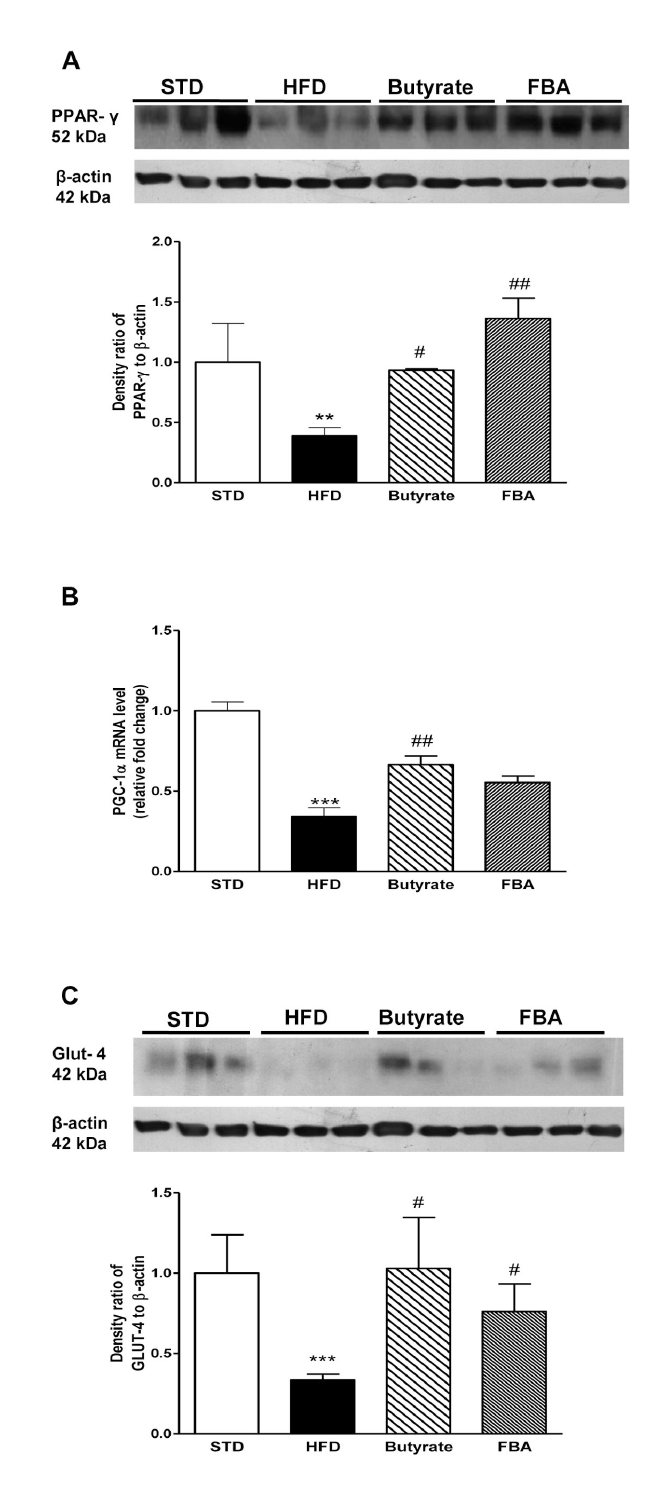
Figure 6. Butyrate and FBA are able to modulate metabolic proteins in adipose tissue. Representative Western blot of PPAR-γ (A) is shown (n=5 each group). Panel B shows real-time PCR results from PGC-1α mRNA levels (relative expression to STD) in adipose tissue (n=6 each group). (C) Western blot analysis of GLUT-4 protein expression in adipose tissue extracts is shown (n=5 each group). **P<0.01 and ***P<0.001 vs STD; # P<0.05, # # P<0.01 vs HFD.